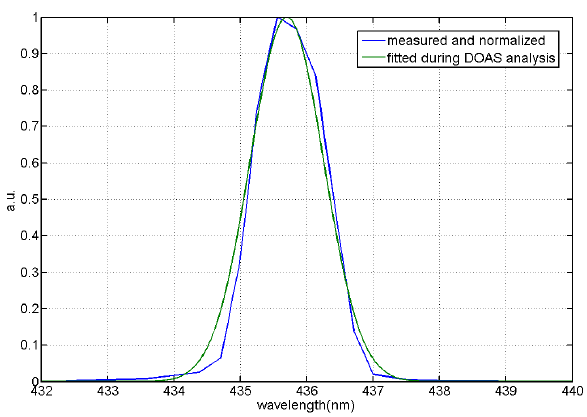
Fig. 4. Slit function measured in the lab using a Hg lamp and fitted from the spectra.